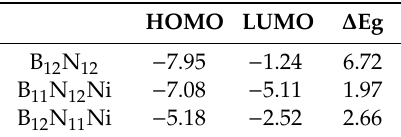
Table 1. The orbital energies on the HOMO and LUMO of B 12 N 12 , B 11 N 12 Ni and B 12 N 11 Ni, and their energy gaps (energies in